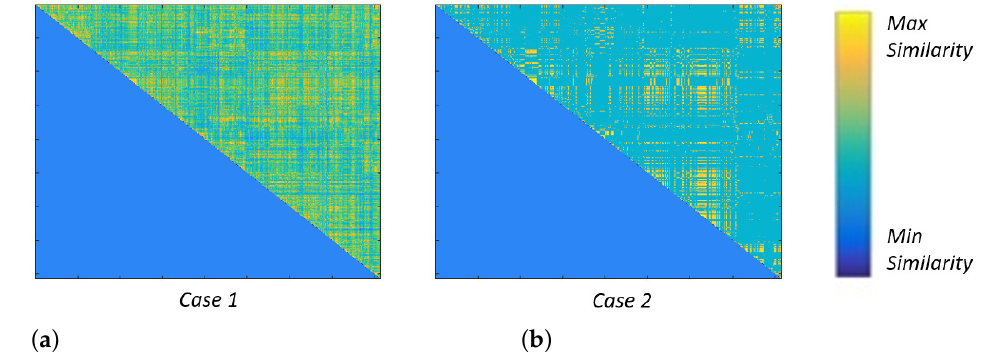
Figure 3. Similarity matrices produced through ( a ) Case 1 and ( b ) Case